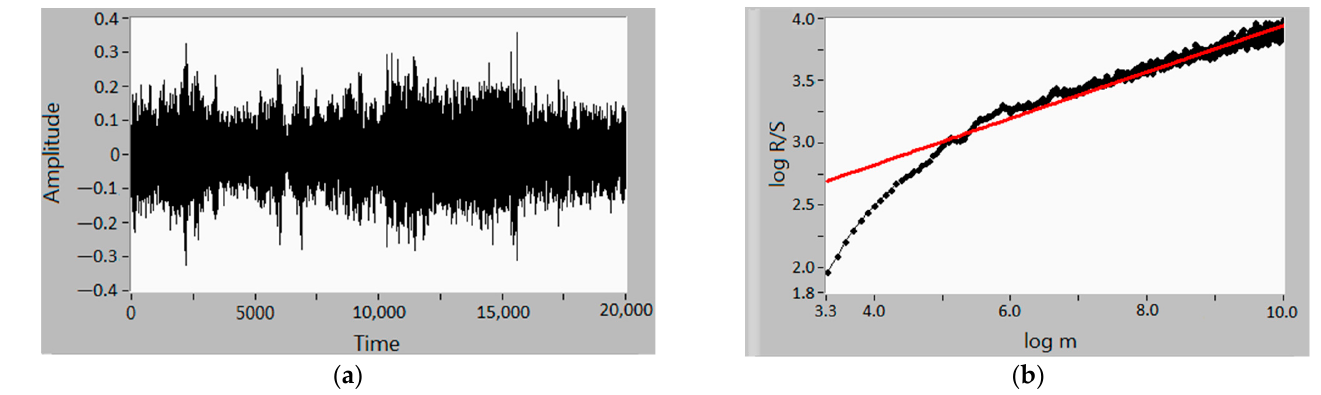
Figure 4. Acoustic signal ( a ) and Hurst dependence graph ( b , red line—regression graph). To analyze the results of experimental studies, an approach typical for anomaly rejection procedures was used. For the set of calculated values of the Hurst exponent, the following algorithm was used.